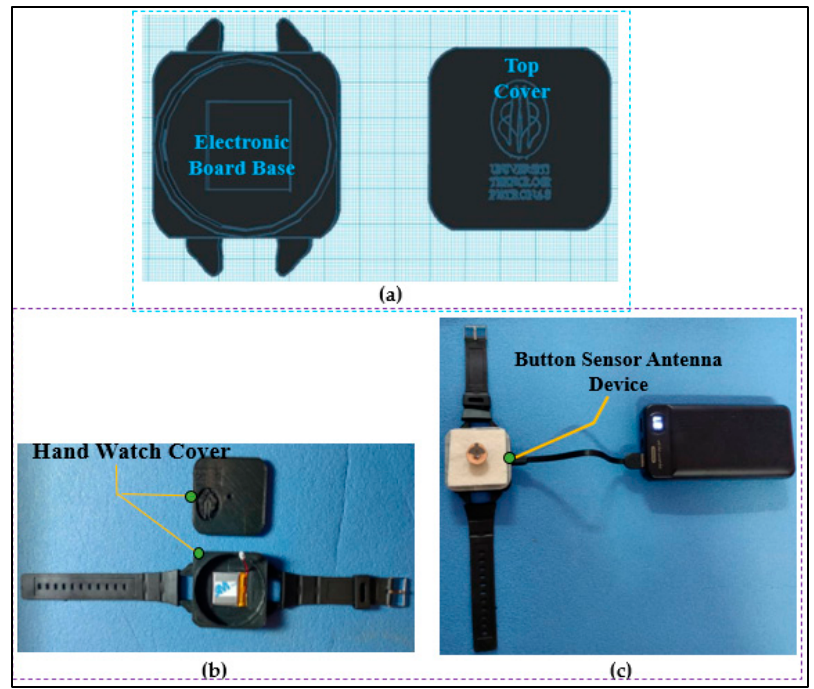
Figure 6. 3D enclosure of a wearable button sensor antenna. ( a ) CAD design, ( b ) fabricated enclosure, and ( c ) full fabricated BSA prototype.